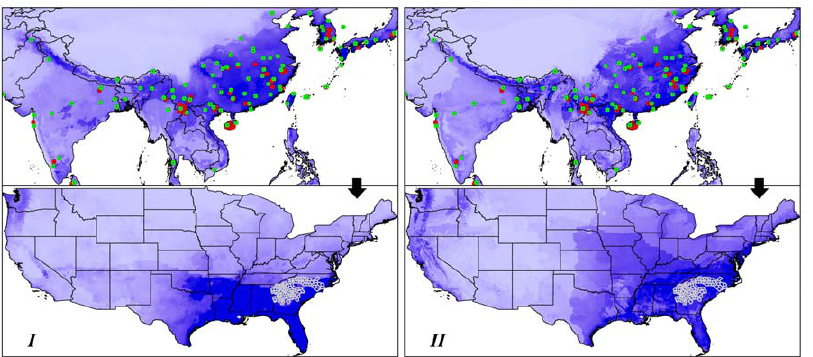
Figure 3. Niche model calibrated on native range and projected onto the US based on Dataset I (left) and II (right). Dark blue color represents high suitability, light blue indicates low suitability. Green dots indicate the occurrence points used for model calibration, red dots indicate the model testing point, white grids in the US indicate the infested counties.